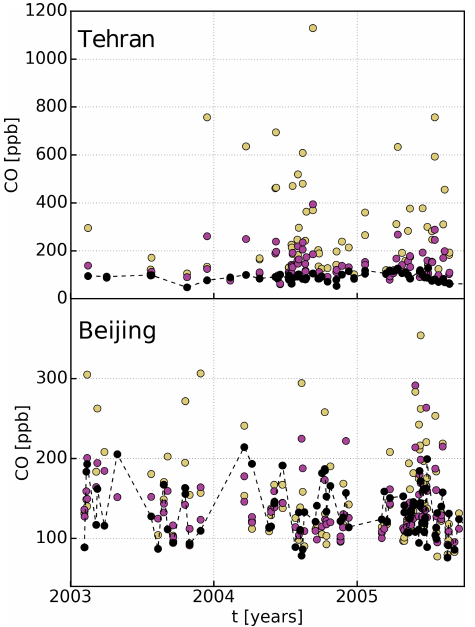
Figure 5. CO column mixing ratios of Tehran and Beijing mea- sured by MOZAIC/IAGOS (yellow), MOZAIC/IAGOS with SCIA- MACHY column averaging kernels applied (pink) and SCIA- MACHY retrievals for optically thick high cloud conditions (black).